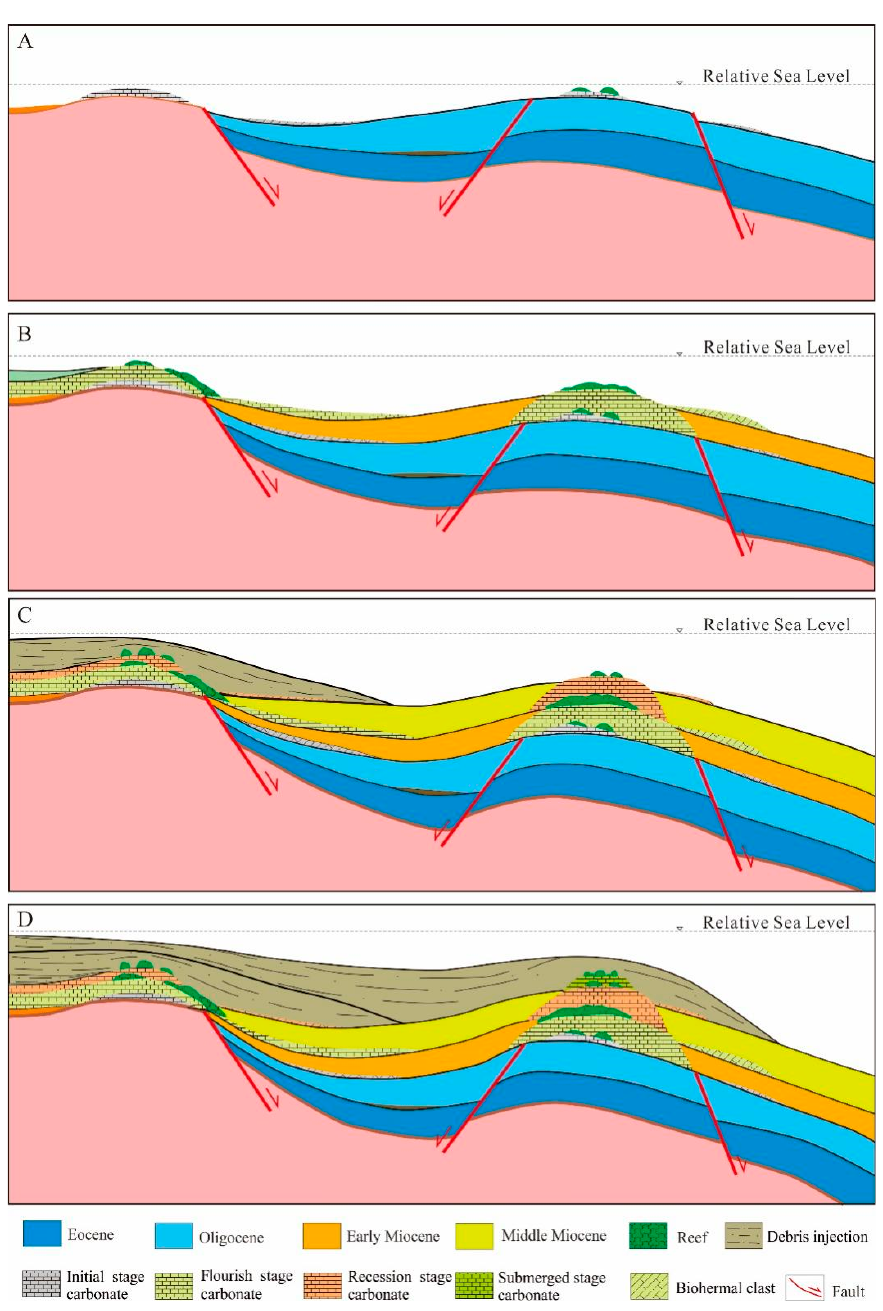
Figure 11. Models of four evolutional phases for the RCPs in Wan’an Basin. ( A ): the initial phase; ( B ): the prosperous phase; ( C ): the recession phase; ( D ): the submerged phase.